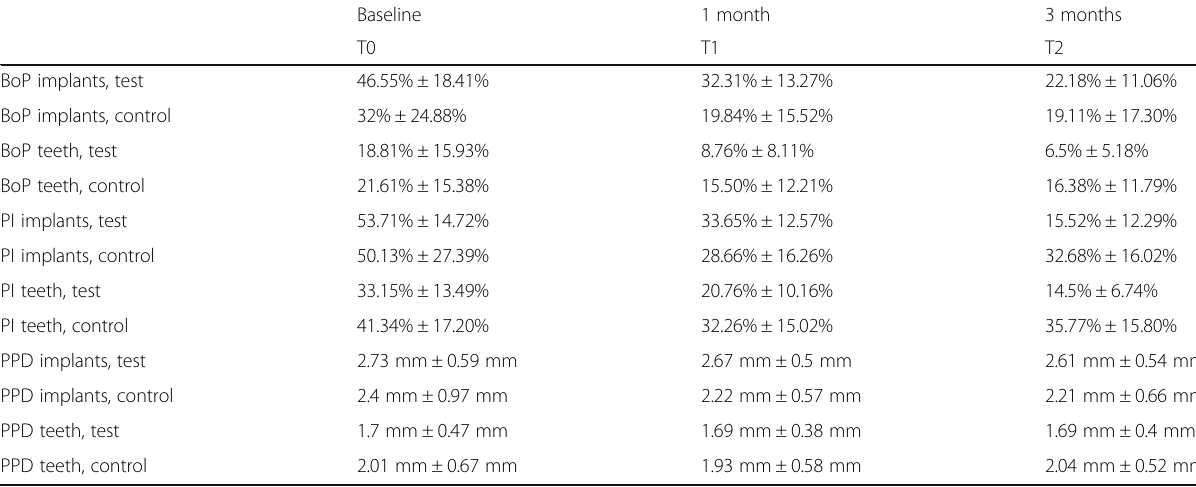
Table 1 BoP, PI, and PPD mean values at baseline, 1 month, and 3 months Baseline